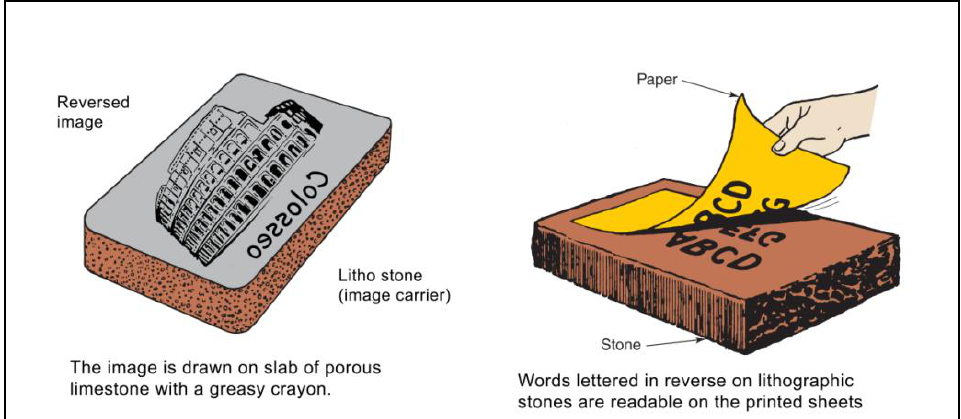
Figure 1. The lithography process uses a stone made of a porous material containing a reversed image. Every lithographic creation requires a pressure of the stone on the paper support, with a subsequent impact on the crayon image reported on it.